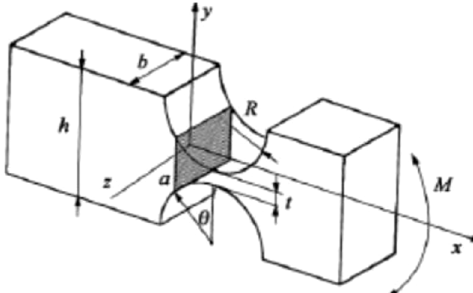
Fig. 3. The single-axis and double-side straight circular fl exure hinge.